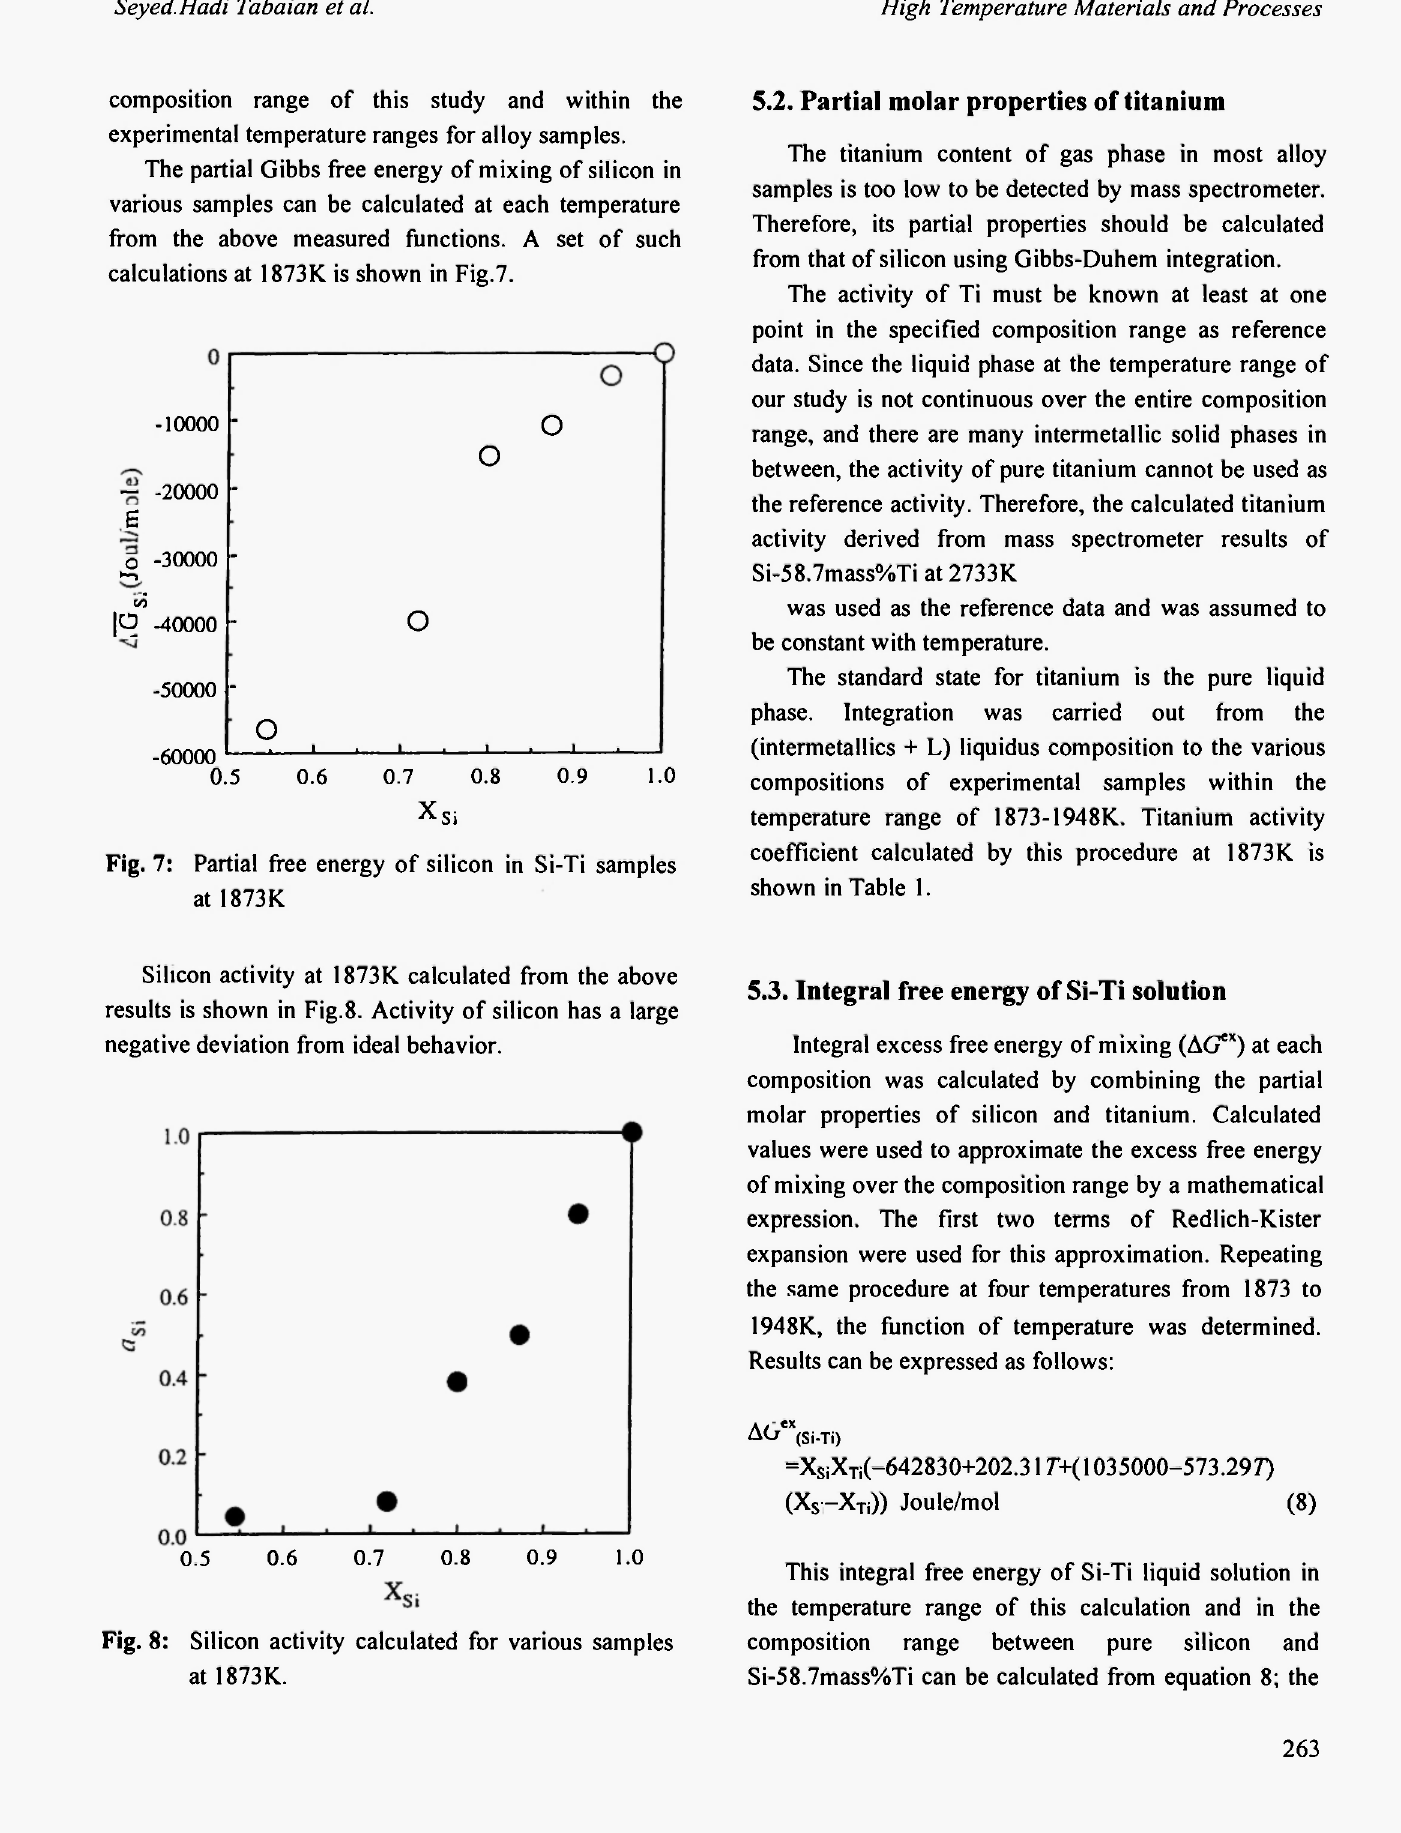
Fig. 8: Silicon activity calculated for various samples at